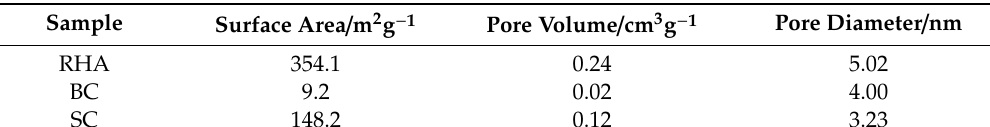
Table 1. Structural parameters of the three carbon materials. RHA: rice husk ash, BC: bamboo charcoal, SC: straw charcoal.